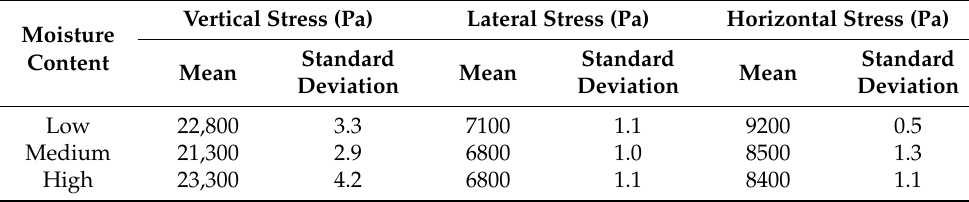
Figure 6. Simulated instantaneous stress distribution curves in all directions from four measuring spheres (MS): ( a ) low moisture content; ( b ) medium moisture content and ( c ) high moisture content. Table 4. Mean values of simulated peak stresses at different soil moisture content